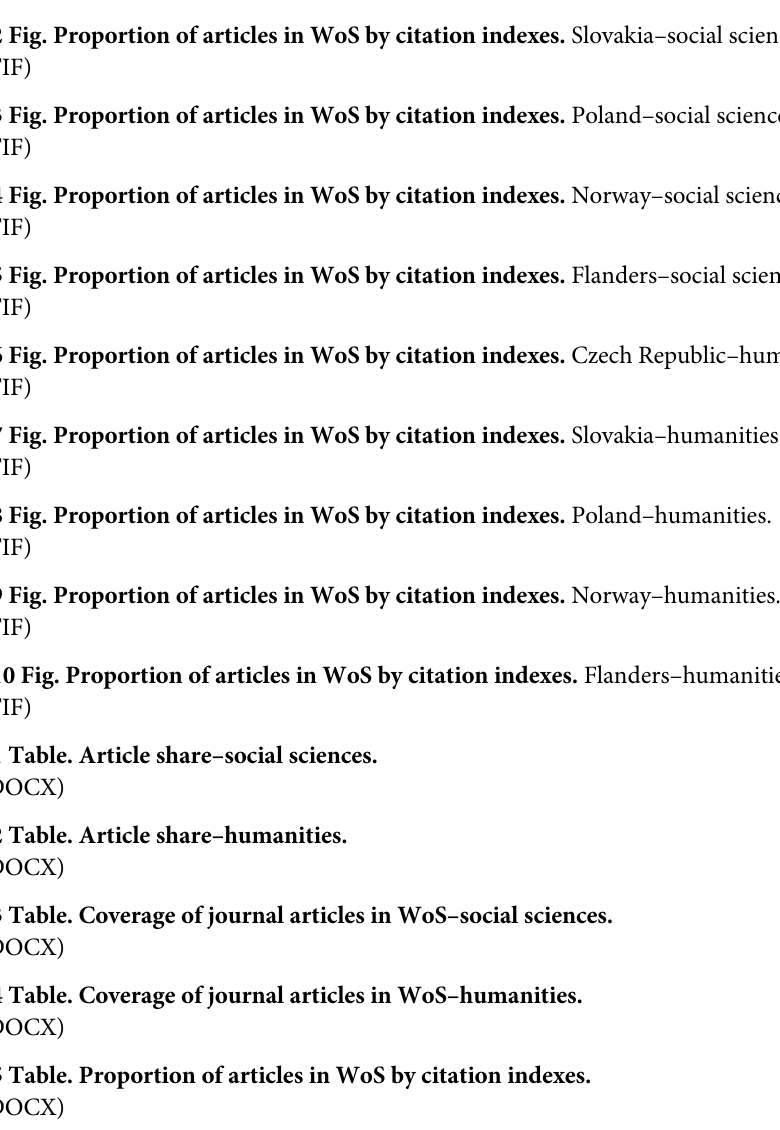
S1 Fig. Proportion of articles in WoS by citation indexes. Czech Republic–social sciences. (TIF) S2 Fig. Proportion of articles in WoS by citation indexes. Slovakia–social sciences. (TIF) S3 Fig. Proportion of articles in WoS by citation indexes. Poland–social sciences. (TIF) S4 Fig. Proportion of articles in WoS by citation indexes. Norway–social sciences. (TIF) S5 Fig. Proportion of articles in WoS by citation indexes. Flanders–social sciences. (TIF) S6 Fig. Proportion of articles in WoS by citation indexes. Czech Republic–humanities. (TIF) S7 Fig. Proportion of articles in WoS by citation indexes. Slovakia–humanities. (TIF) S8 Fig. Proportion of articles in WoS by citation indexes. Poland–humanities. (TIF) S9 Fig. Proportion of articles in WoS by citation indexes. Norway–humanities. (TIF) S10 Fig. Proportion of articles in WoS by citation indexes. Flanders–humanities. (TIF) S1 Table. Article share–social sciences. (DOCX) S2 Table. Article share–humanities. (DOCX) S3 Table. Coverage of journal articles in WoS–social sciences. (DOCX) S4 Table. Coverage of journal articles in WoS–humanities. (DOCX) S5 Table. Proportion of articles in WoS by citation